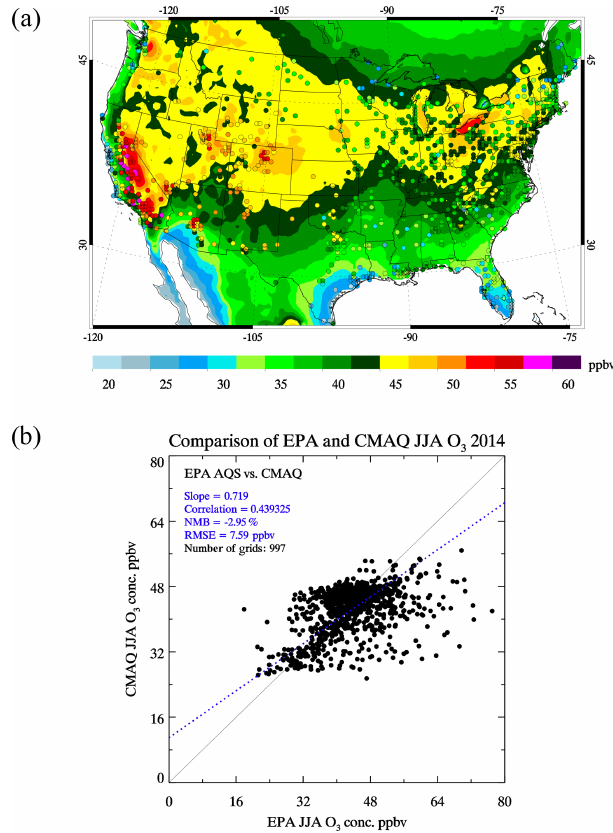
Figure 5. Comparison of summer MDA8 ozone concentrations from EPA AQS observations and CMAQ simulations in 2014. AQS station data were gridded to the CMAQ grid using the EPA RSIG software. (a) Contour plot, the background stands for the CMAQ outputs and the dots stand for gridded AQS observations; (b) scat- ter plot of the gridded AQS observations and collocated CMAQ out-